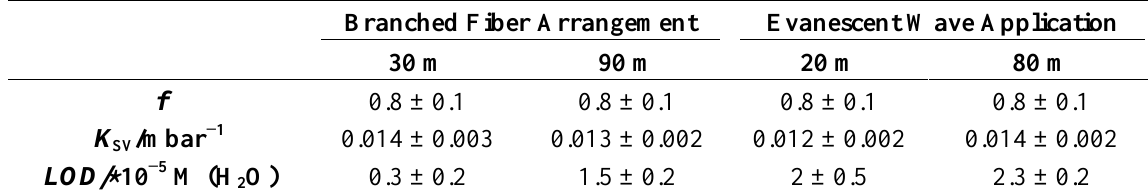
Table 1. Determined values for f and K of branched fiber model and of evanescence SV wave application. Limit of Detection ( LOD ) were determined by linear fit of 0 mbar-100 mbar, calculating with Henry constant (0.0013 mol/kg∙bar [27]) resulting LOD of oxygen in water in